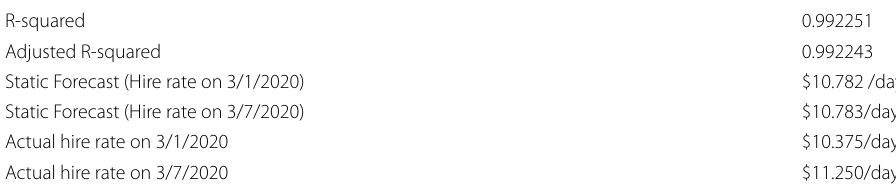
Table 9 One-year time-charter 75.000 dwt. Source : Elaboration by the authors